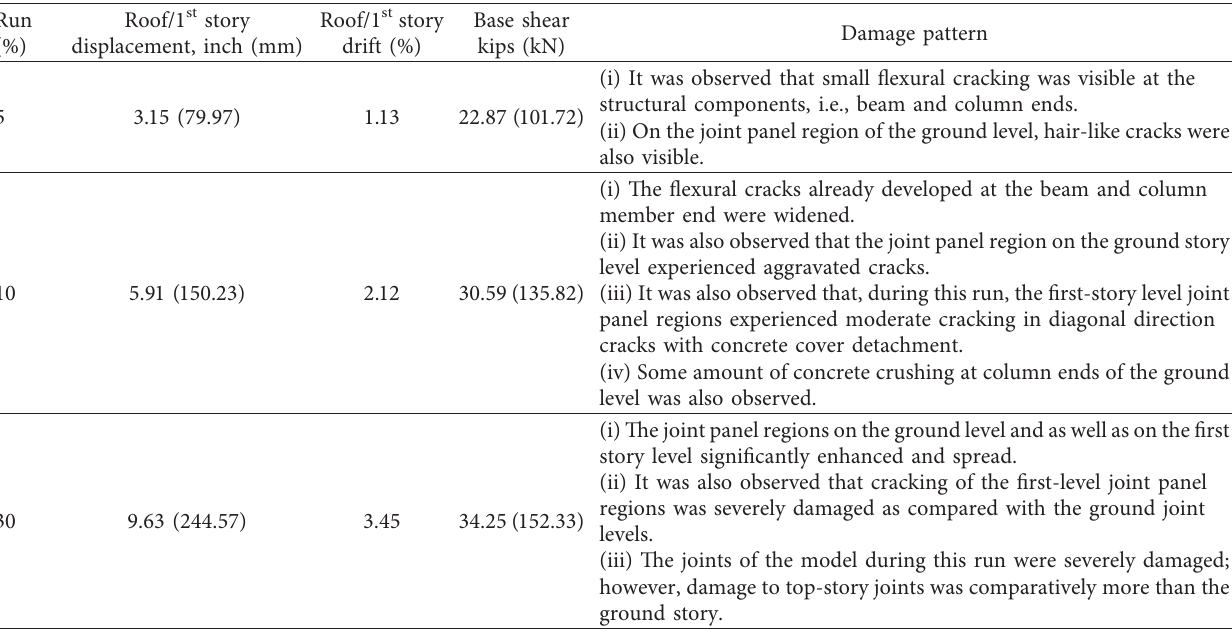
Table 2: Observed response and damage condition of Model-2 under significant